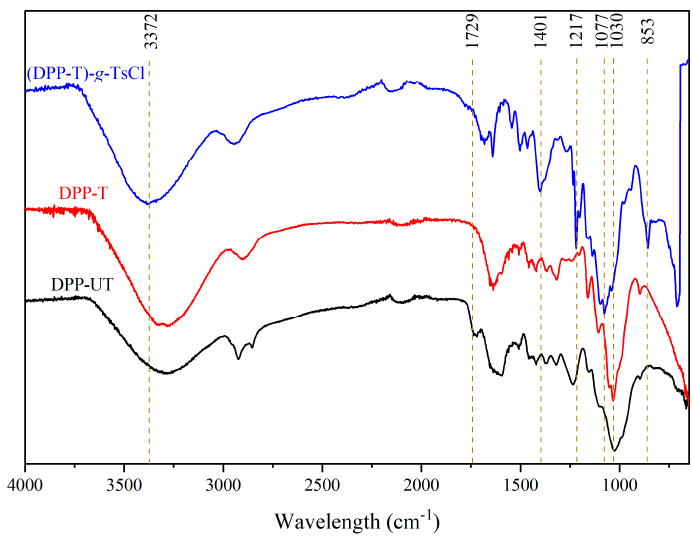
Figure 3. FTIR spectra of DPP-UT, DPP-T, and (DPP-T)- g -TsCl.